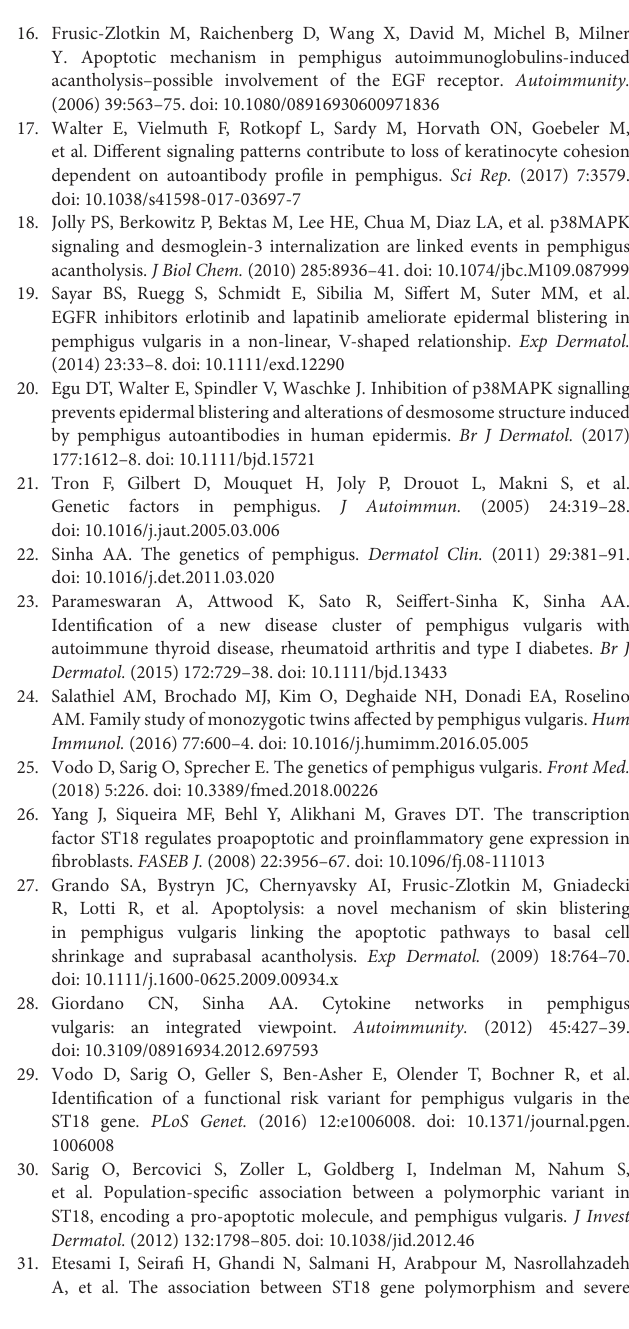
Supplementary Figure 1 | NHEK monolayers treated with c-IgG, AK23 and PV-IgG were immunostained for Dsg3. Representative immunofluorescence images from n ≥ 4. Bar scale is 20 µ m.